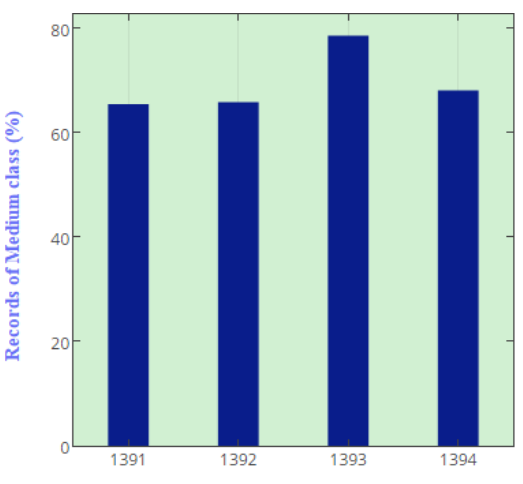
Figure 7. Ayandeh Bank